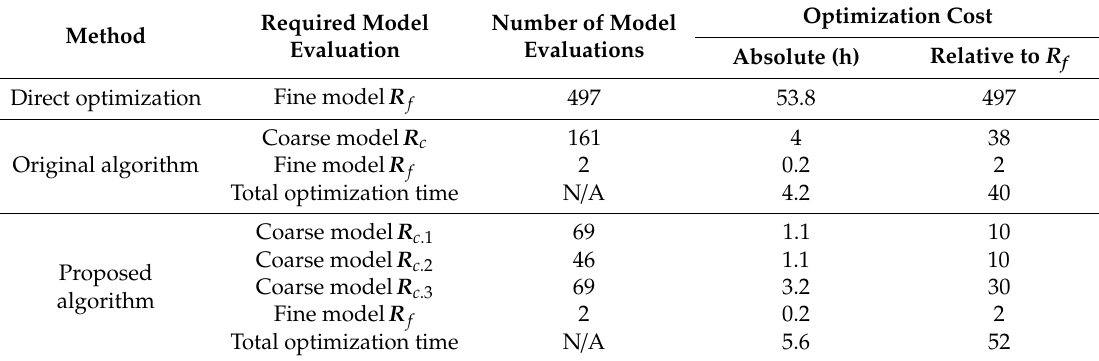
Table 2. A UWB monopole antenna: optimization cost.